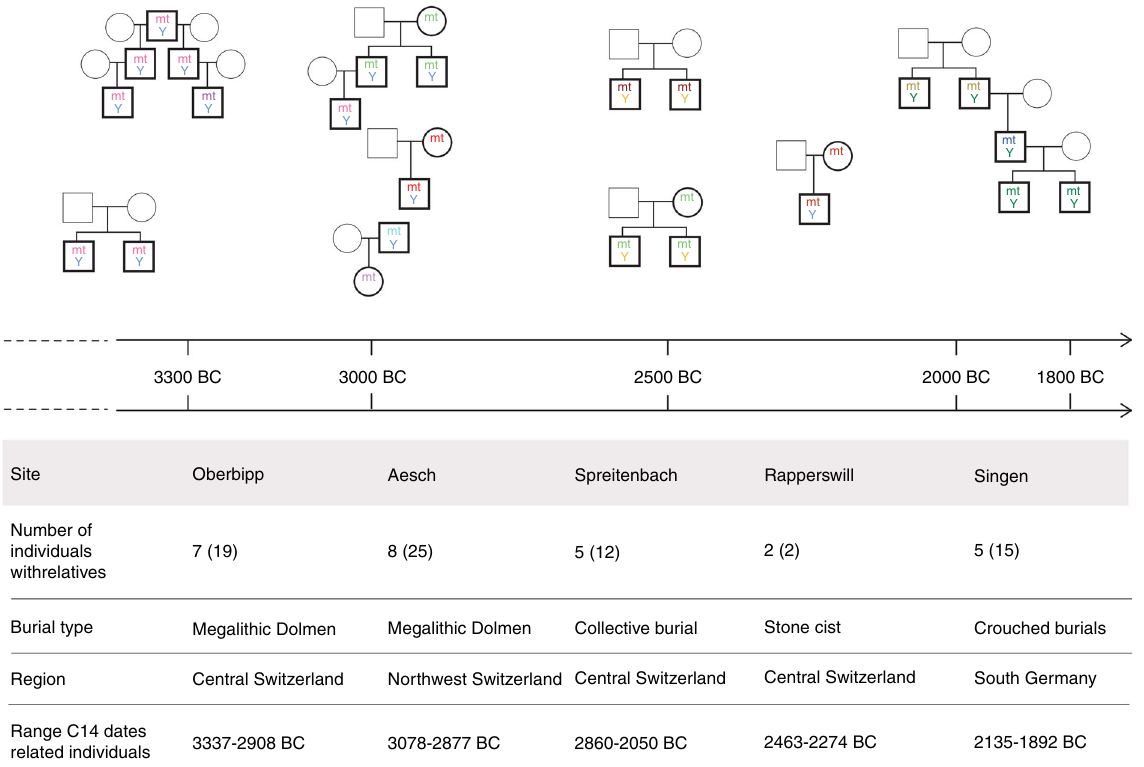
Fig. 4 Reconstructed family trees from different sites over time. All relationships between the single individuals were reconstructed from autosomal variants and con fi rmed by uniparentally inherited markers such as mtDNA haplotype and Y chromosomal haplogroup. Individuals with black outline were available for analysis and individuals with gray outline were not found within the burials and are missing. Same colors indicate identical mtDNA haplotypes and matching Y chromosomal